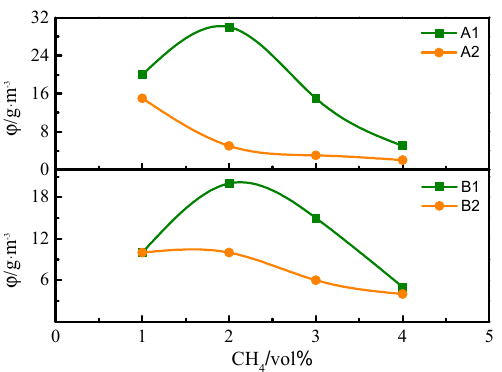
Figure 5. Decreasing amplitude of the minimum explosion concentration of coal dust varying with methane concentration.